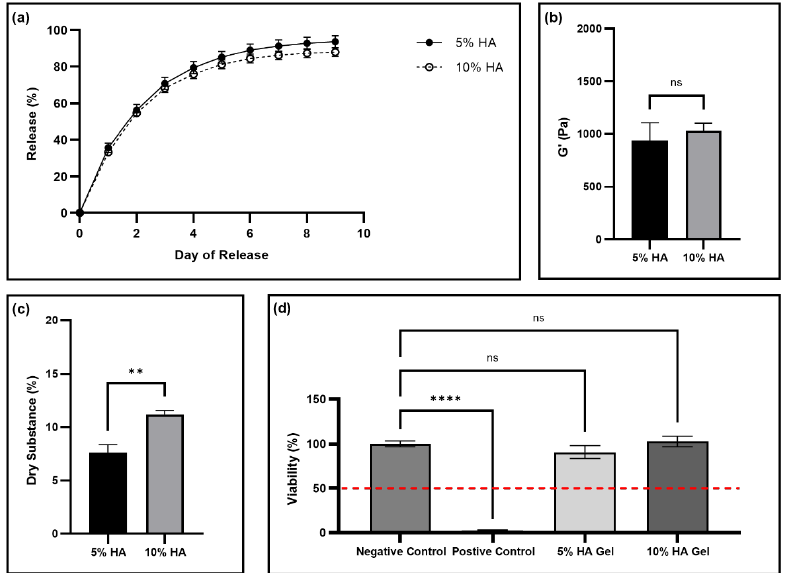
Figure 4. Evaluation of gels made with 5 and 10% w / v HA. ( a ) The release profiles of fluorescein with N = 3. Error bars hidden by plot symbols when not visible. A t -test was used to compare release from gels made from 5% versus 10% w / v HA each day, resulting no significant p -values (Table S4). ( b ) Storage moduli for gels made with different concentrations of HA. Mean and standard deviation are displayed from data collected with N = 3. An unpaired t -test was used to compare the means, resulting in a p = 0.5576, with ns indicating no significant difference between the means. ( c ) Dry substance percentage for gels made with different concentrations of HA. Mean and standard deviation are displayed from data collected with N = 3. An unpaired t -test was used to compare the means, resulting in a p = 0.0018, with ** indicating p < 0.01. ( d ) Skin relative viability compared to negative control tissue treatment of PBS to tissues treatment with positive control (5% SDS solution), 5% HA gel, and 10% HA gel, with N = 3 for the control groups and N = 6 for the treatment groups. The dashed line at the viability 50% indicates the cut off for a substance being a non-irritant, with all substances above the line being designated as a non-irritant. The treatments were compared to the negative control using a one-way ANOVA, with **** indicating p < 0.0001, and ns indicating not